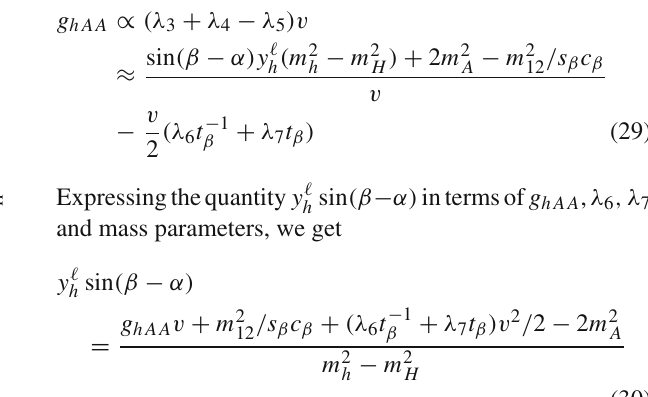
Fig. 4 Parameter space satisfying electroweak constraints in the plane of m A and m H − m H ± with m H ± as the color-axis